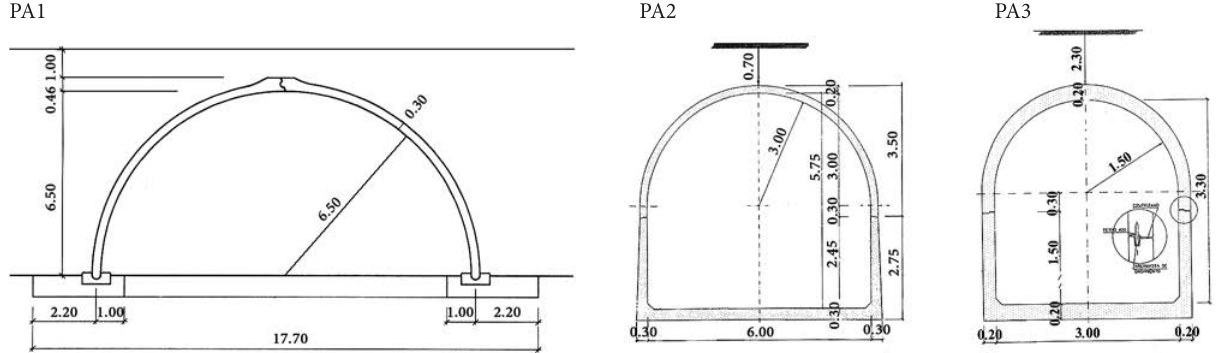
Fig. 2. Cross-section of the three types of underpasses studied (dimensions